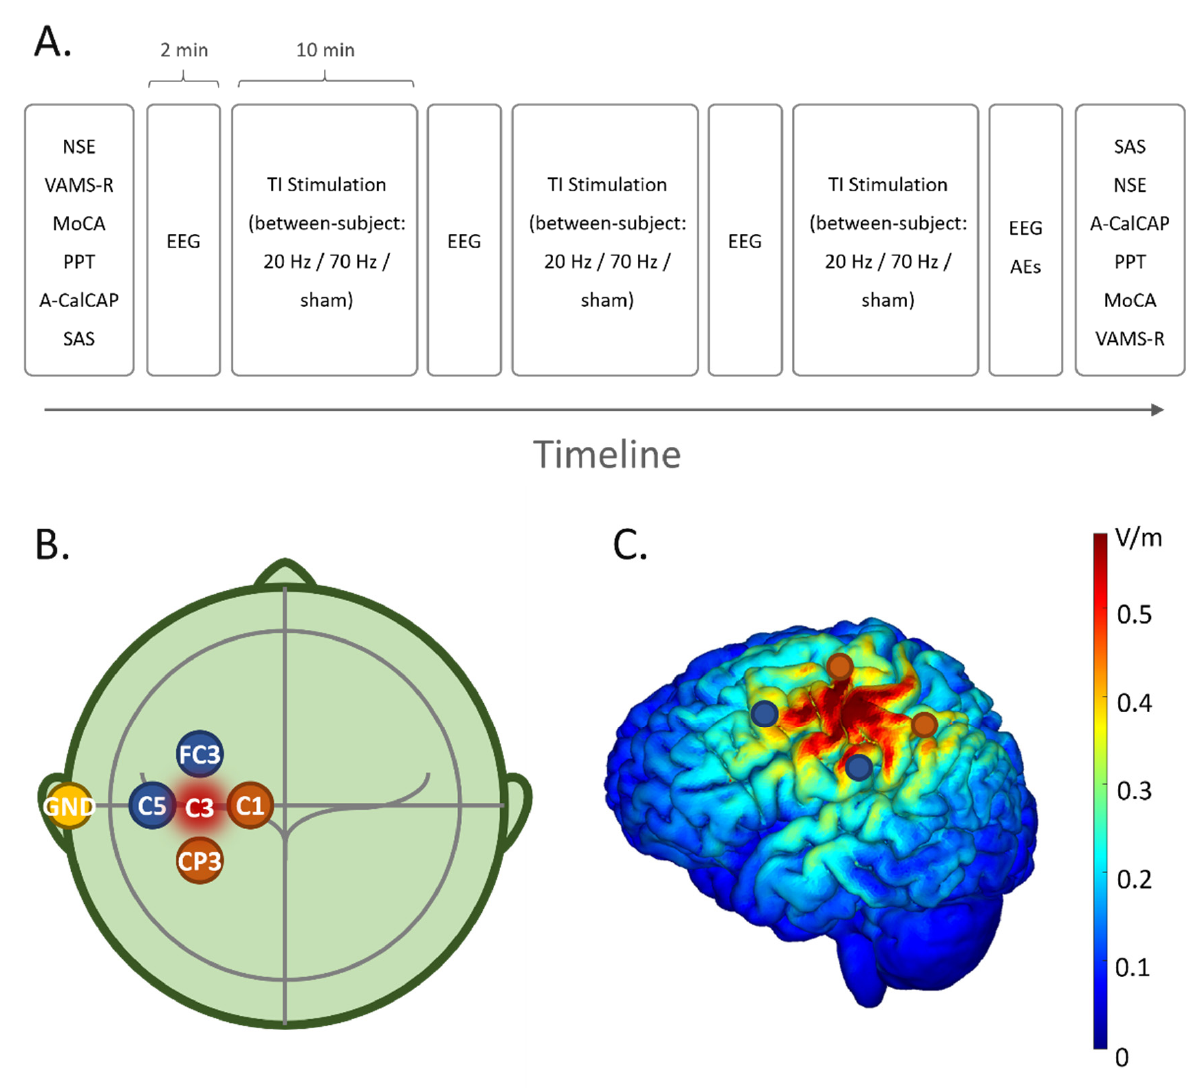
Figure 2. ( A ) Experimental design. Before and after the stimulation, participants completed the neurological (NSE) and neuropsychological (MoCA, A-CalCAP, PPT, VAMS-R, SAS) measures. Participants received 3 blocks of 10-min active (20 Hz: N = 9 or 70 Hz: N = 10) or sham (no current was applied: N = 19) TI-tACS. An eye-closed resting state electroencephalograph (EEG) was recorded for 2 min immediately before and after a 10-min TI-tACS. During the TI-tACS, participants wore the EEG cap all the time. After the last EEG recording, participants reported adverse effects (AEs) of TI-tACS by filling out a subjective questionnaire. The order of VAMS-R, MoCA, PPT and A-CalCAP was balanced among participants and the order of the post-test was inverse to that of the pre-test in each participant. ( B ) Location of stimulation electrodes and the target region. Based on the international 10–20 system, to stimulate the left primary motor cortex (C3), two pairs of stimulation electrodes (FC3, C5; CP3, C1) were placed approximately 30 mm around the target region. Additionally, the ground electrode (GND) was placed at the left mastoid. ( C ) Simulation head model with the intensity of the electric field. NSE: Serum neuron-specific enolase; MoCA: Montreal Cognitive Assessment; A-CalCAP: an abbreviated version of the California Computerized Assessment Package; PPT: Purdue Pegboard Test; VAMS-R: revised version of the Visual Analog Mood Scale; SAS: self-assessment